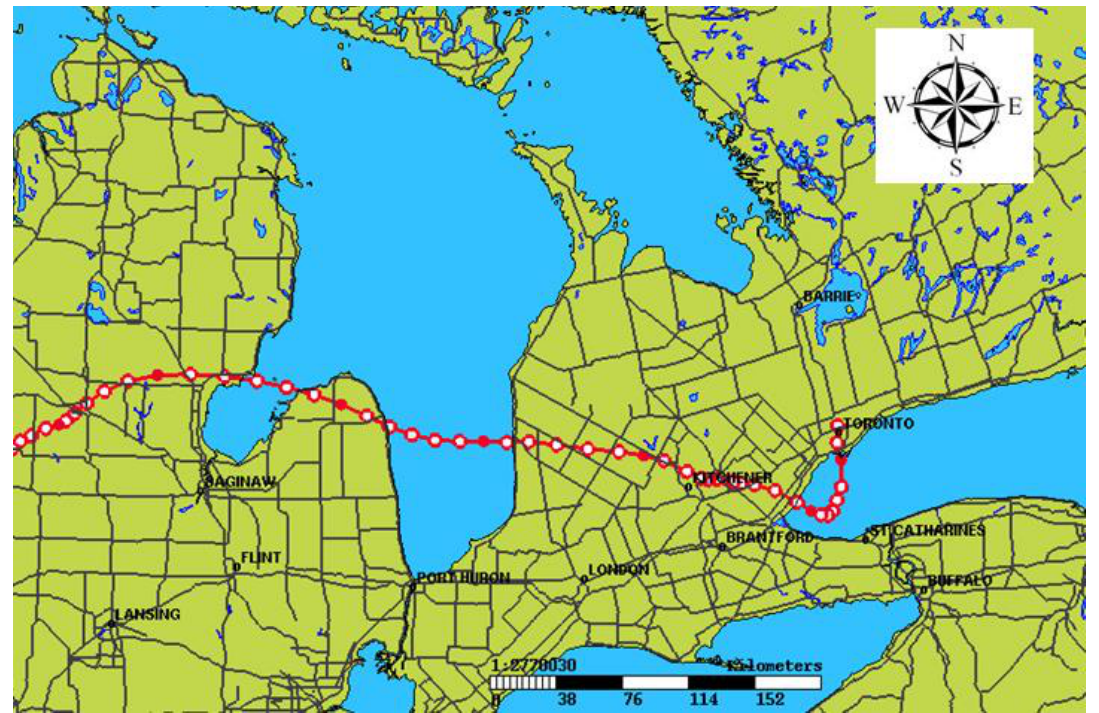
Figure 10. A 48-h air mass back trajectory calculated from the 2.5-km GEM-MACH-TEB output ending at the North Toronto station at a height of 175-m on 12 June 2015 at 20:00 UTC. A 96-h HYSPLIT backward trajectory was also run for each case using the GDAS (global data assimilation system) data. Both cases were similar in that the 96-h trajectories originated from the